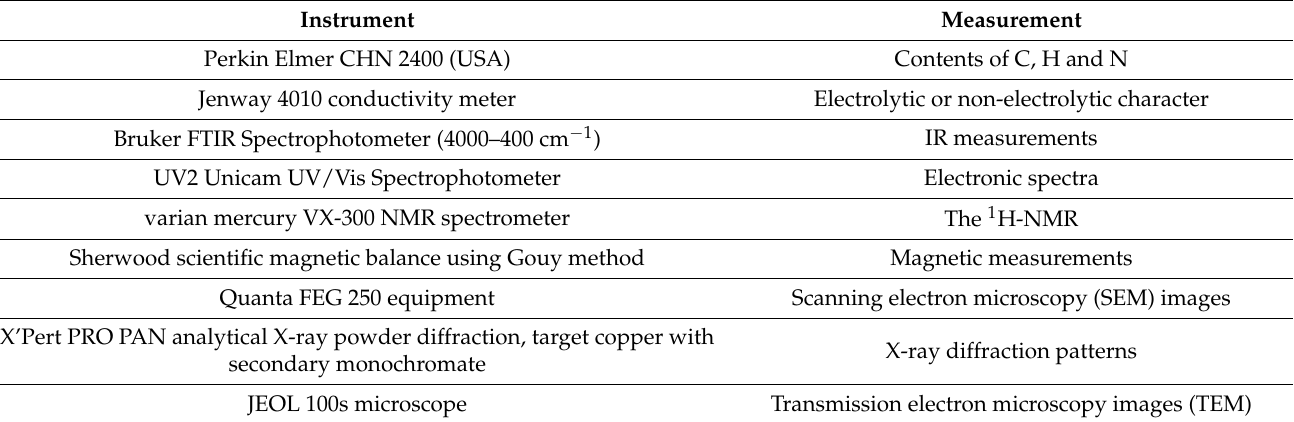
Table 1. Instrumentations and experimental